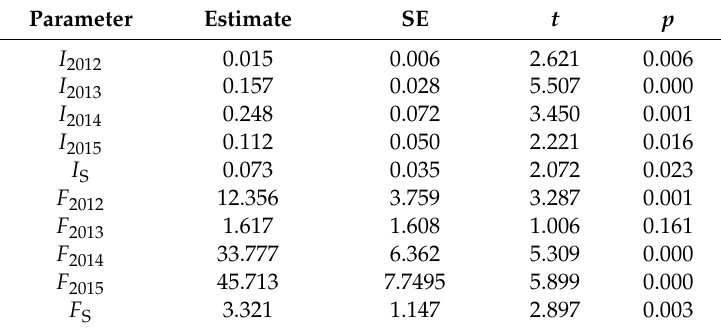
Table 4. Parameter estimates of Equation (5) describing the relationship between egg and surviving adult density in the 5 datasets available in this study. R 2 = 0.92. The t statistics tests the hypothesis that the term is